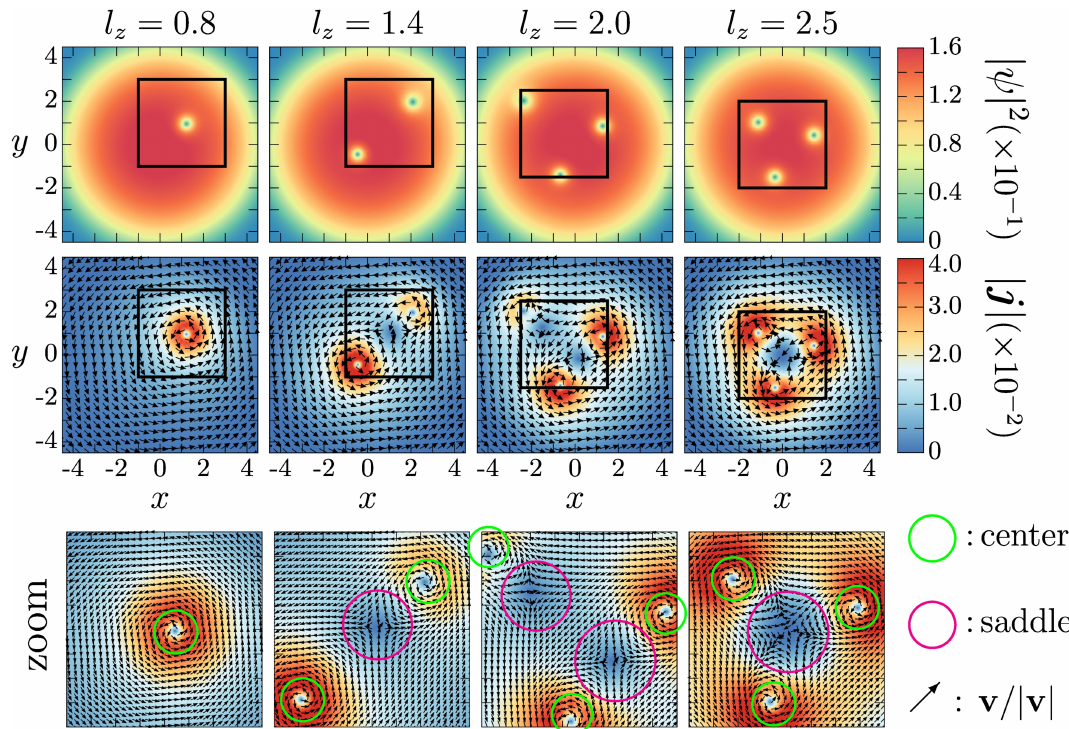
Figure 2 . The panels on the different columns show examples of the minimal energy configurations of eq. (2.7), that satisfy L z = l z and N = 1 for the dimensionless coupling g = 400 . The panels on the top row show the density | ψ | 2 ; it vanishes at the vortex core. The squares denote the regions that are zoomed-in, on the bottom panels. The middle panels show the corresponding vector field v ( x ) . The color map shows the amplitude of the current j = | ψ | v , while the arrows show the superflow vector field v ( x ) . The bottom row shows the corresponding data zoomed closer to the various fixed points of v ( x ) . The green and magenta circles highlight the vortex cores i.e. centers of v ( x ) and stagnation points i.e. saddles of v ( x ) , corresponding to different trajectories Γ in eq. (2.4). Both the vortex cores and the stagnation points are characterized by a vanishing superflow | j ( x ) | = 0 . Unlike the vortex cores, where the density | ψ | vanishes, at the stagnation points | ψ | 6 = 0 . This can be seen by comparing the data for the current j := | ψ | v , with the density | ψ | 2